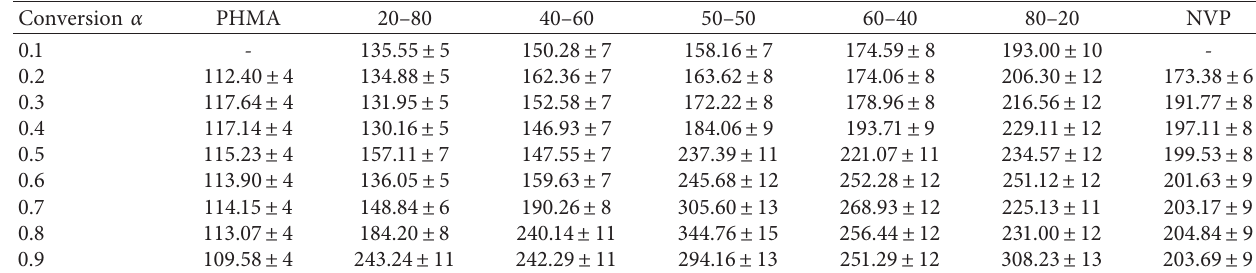
Table 4: Activation energies (KJ) by the OWF method for the PNVP- co -PHMA copolymers.